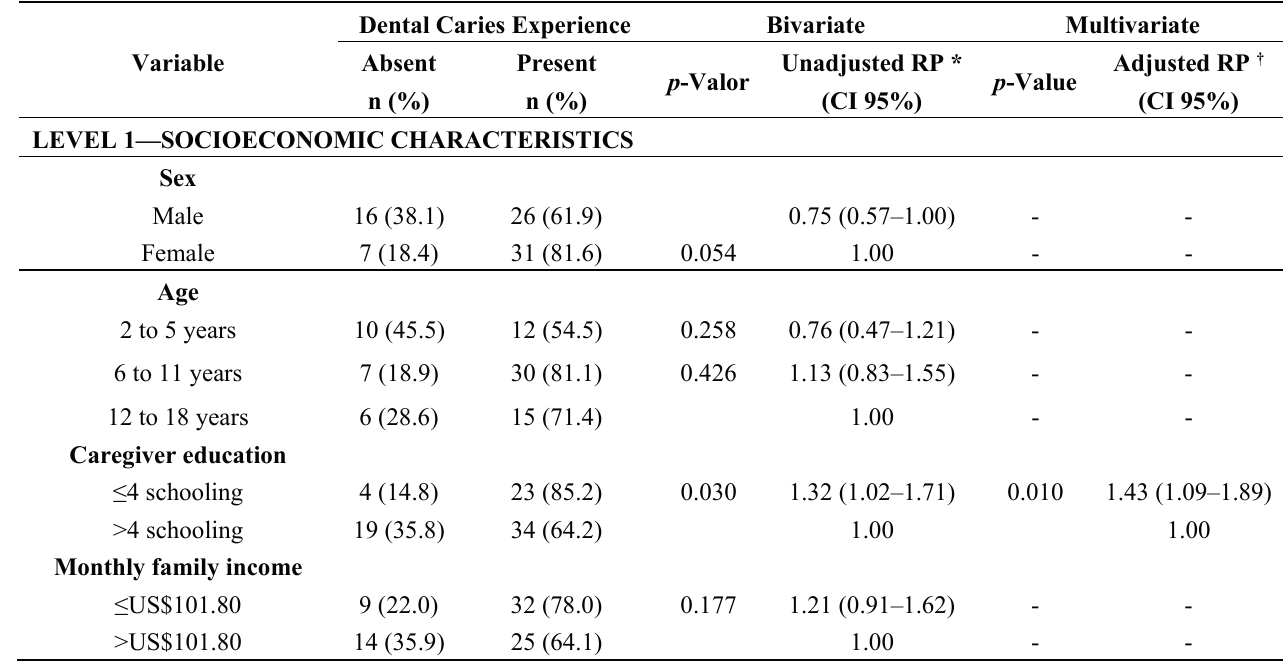
Table 5. Distribution of children and adolescents with CP in Poisson regression bivariate